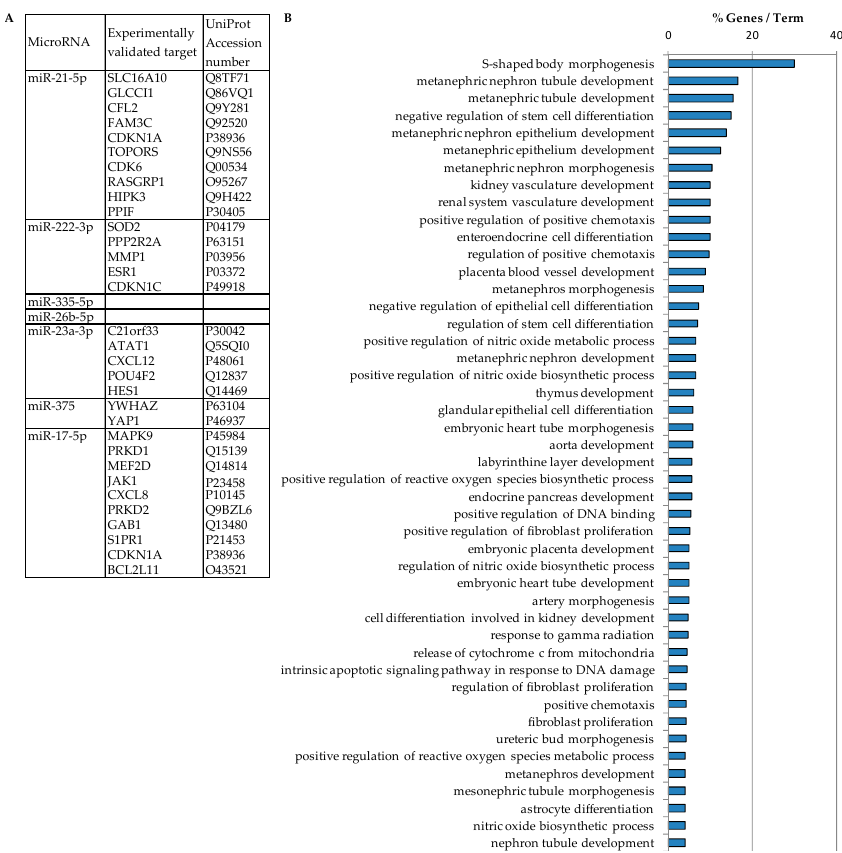
Figure 3. Functional annotation enrichment analysis of the 7 miRNA’s targets. ( A ) Targets of miRNAs were predicted by miRecords database. No targets have been described for miR-335-5p and miR-26b-5p. ( B ) Biological processes of miRNA’s target genes were predicted by Cytoscape plugin ClueGO and Cluepedia applications ( p < 0.05).